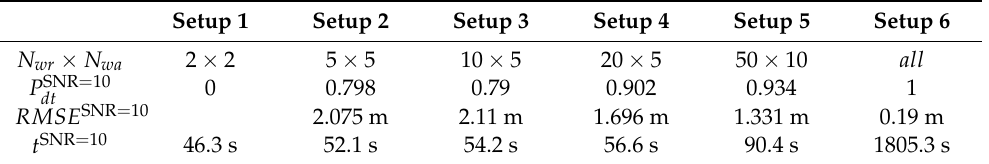
Figure 5. Statistical characteristics of reverberation and target echo data, showing the fitting results when: ( a ) the SRR is 10 dB. ( b ) the SRR is − 5 dB. The six setups represent six different sizes of the sub-area. The stable detection and tracking probability, the position’s root mean square error, and the computation time are compared in Table 1. Table 1. Simulation results of the different